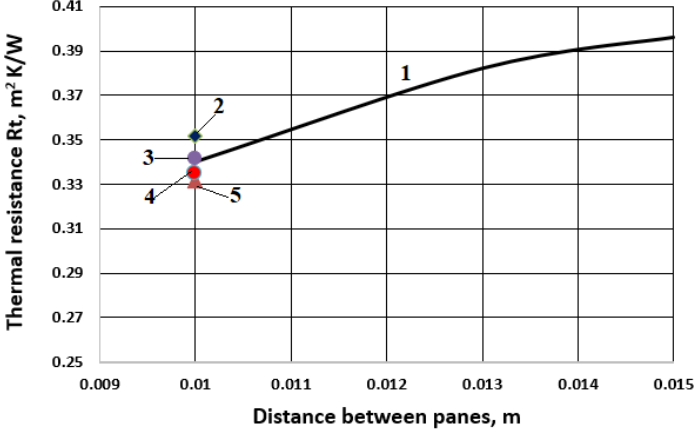
Figure 11. Comparison of calculated and experimental values from IET NAS of Ukraine for thermal resistance of a two-chamber glass window: 1—results of calculations in the CFD Star CCM package; 2–5—experimental data from IET NAS of Ukraine—January–March 2015 [29].